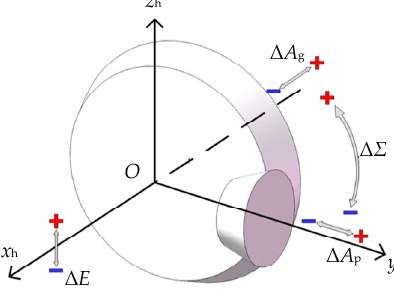
where ∆ E is the offset error; ∆Σ is the shaft angle error; ∆ A p is the pinion axial error; ∆ A g is